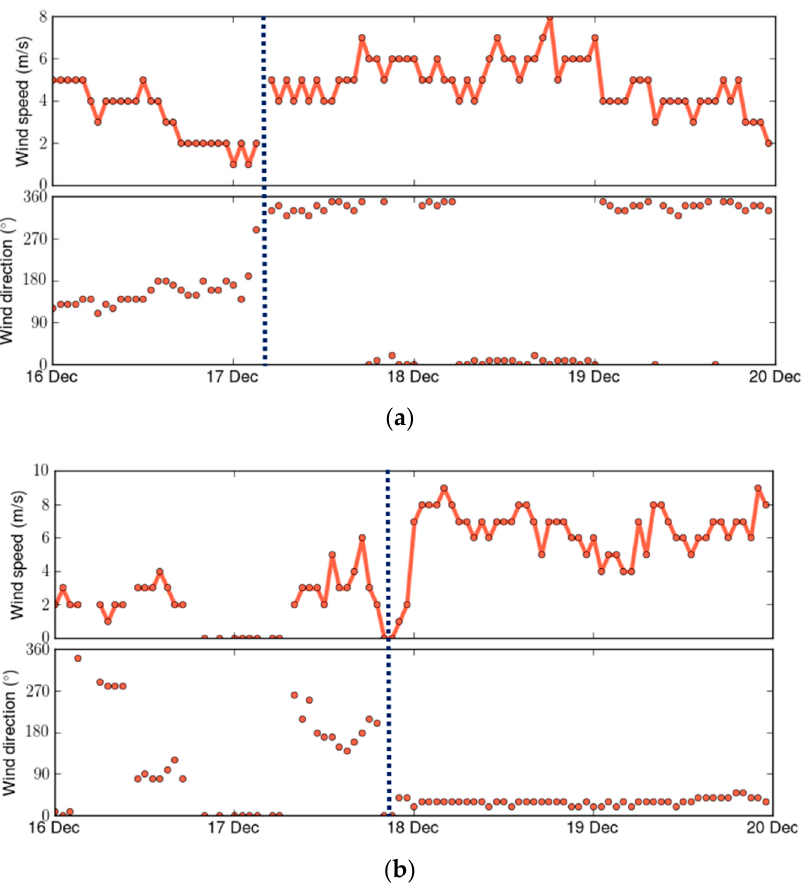
Figure 3. Time series of wind speed and direction at ( a ) Shanghai and ( b ) Fuzhou from 16 to 19 December 2019. Dotted lines mark the time when the cold front arrived at the cities.